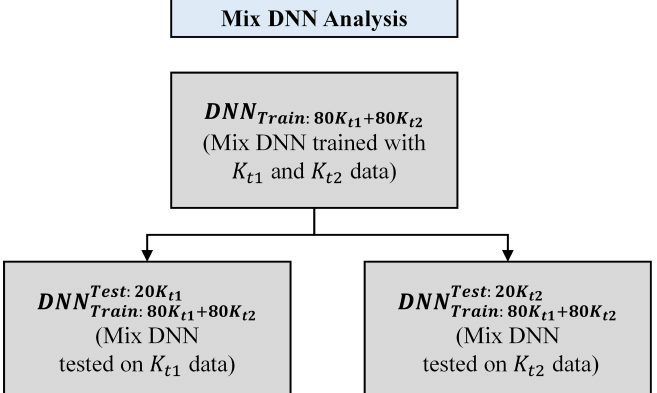
Figure 11. A single mixed DNN ( DNN Train :80 K both K t 1 and K t 2 data; tested on data from both K t s